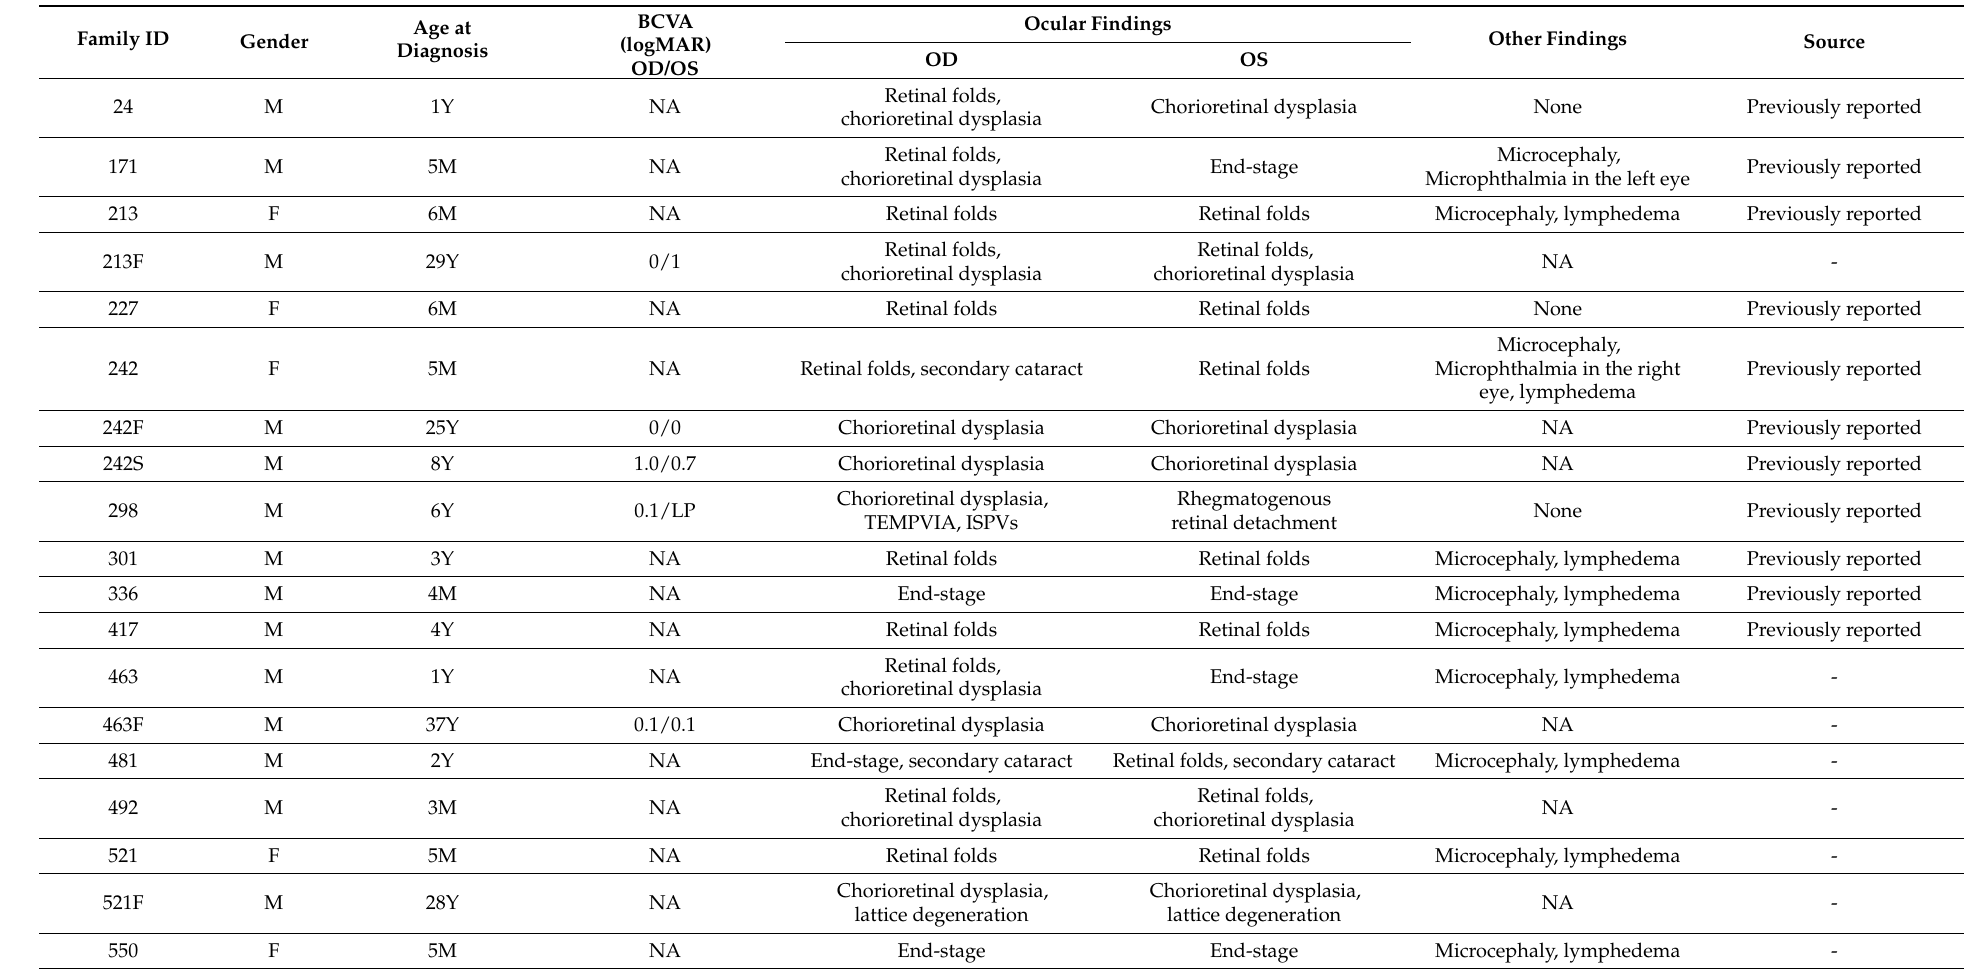
Table 1. The ocular manifestations of 35 subjects with KIF11 associated